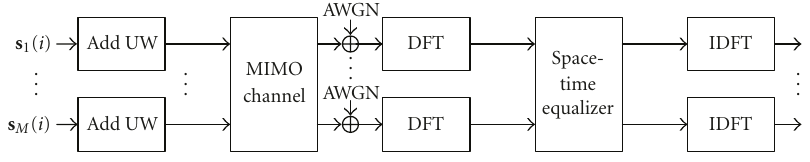
Figure 2: Block diagram of a MIMO UW system that performs channel equalization in the frequency domain.